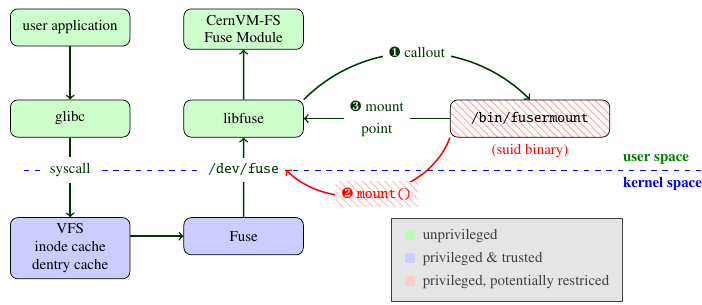
Figure 1. A successful Fuse mount returns a file descriptor to / dev / fuse, which is subsequently used by the fully unprivileged Fuse module